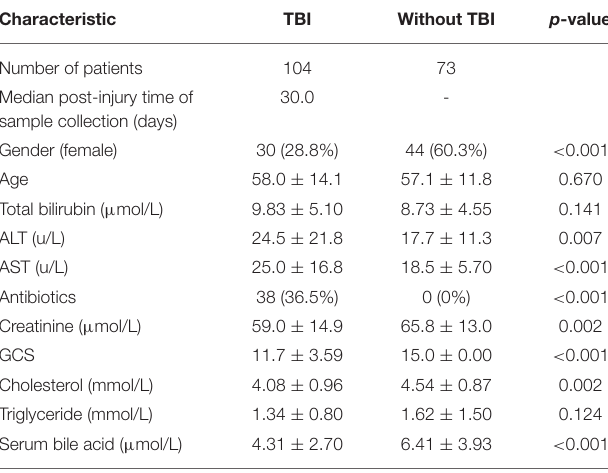
TABLE 1 | Characteristics of patients. TABLE 2 | Differences between patients with or without